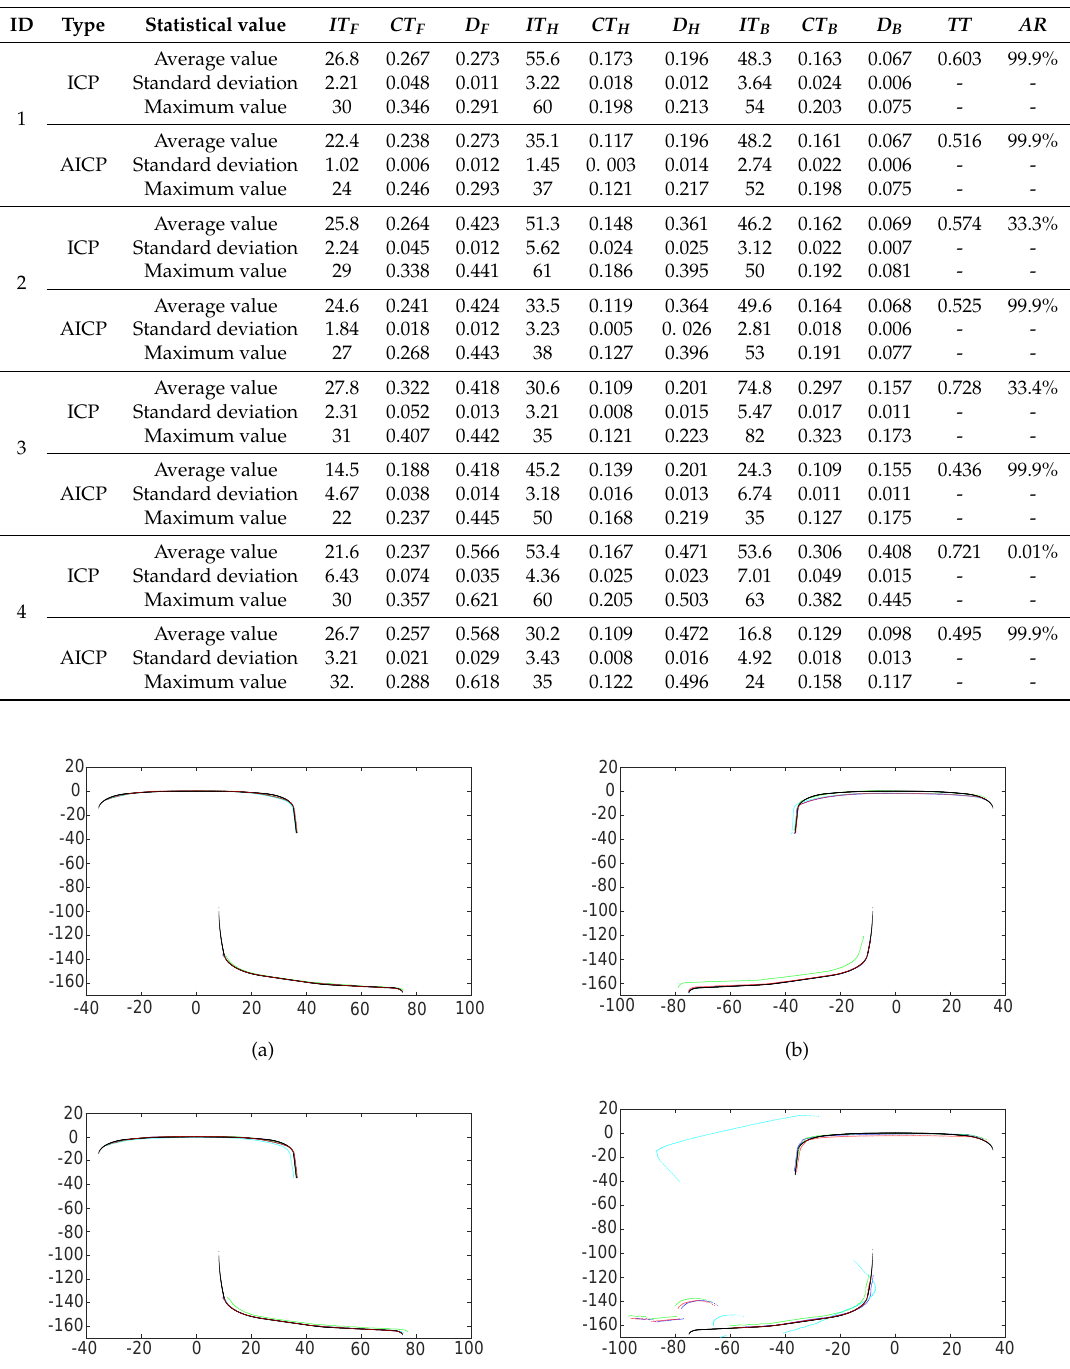
Table 2. Effect of AICP and ICP.